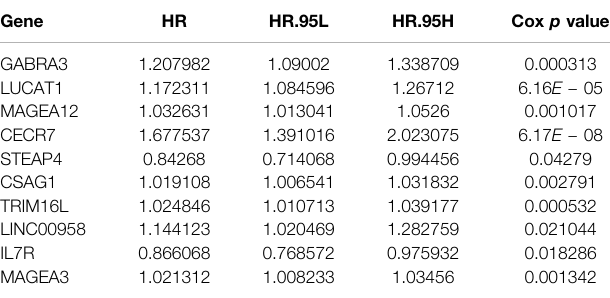
TABLE 3 | Univariate cox analysis of TMB related genes combined with immune in fi ltrates in HCC. Gene HR HR.95L HR.95H Cox p value